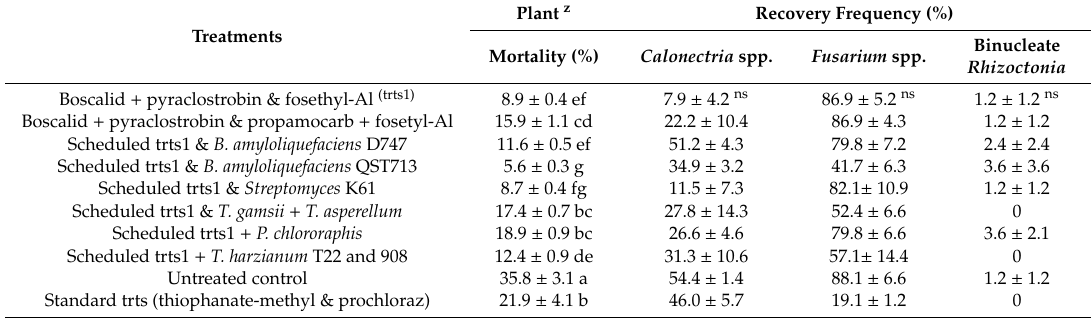
Table 4. E ffi cacy of treatments in reducing milkwort decline in experiment IV under natural infection after 5